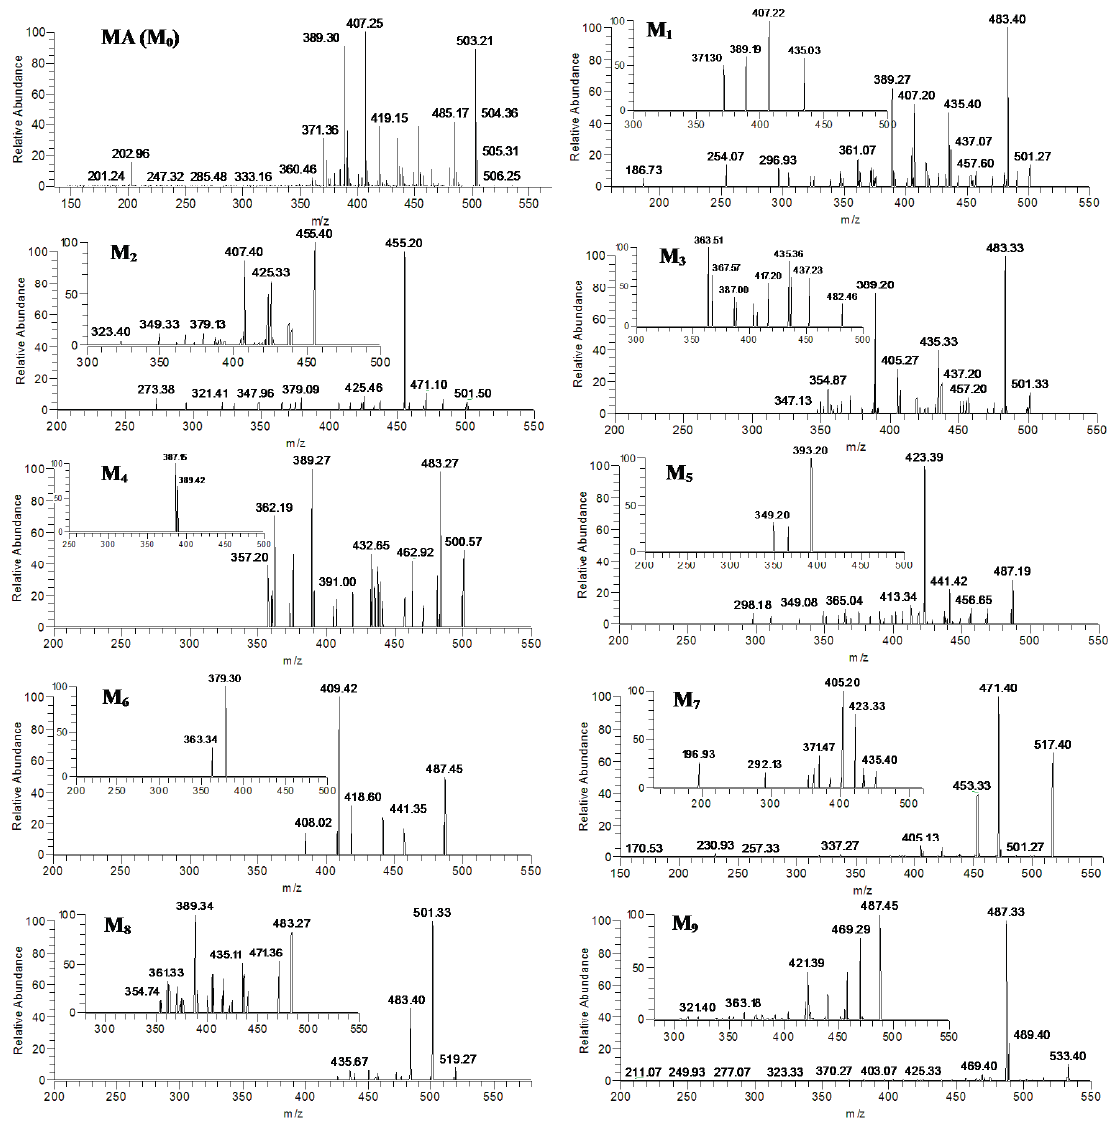
Figure 5. The MS n ( n = 2–3) spectra of the metabolites (M 0 –M 10 ) of MA after zebrafish exposure: M 0 ( m / z 503); M 1 , M 3 ( m / z 501, m / z 501 → 483), M 2 ( m / z 501, m / z 501 → 455), M 4 ( m / z 501, m / z 501 → 389); M 5 ( m / z 487, m / z 487 → 423); M 6 ( m / z 487, m / z 487 → 409); M 7 ( m / z 517, m / z 517 → 471); M 8 ( m / z 519, m / z 519 → 483); and M 9 ( m / z 533, m / z 533 →